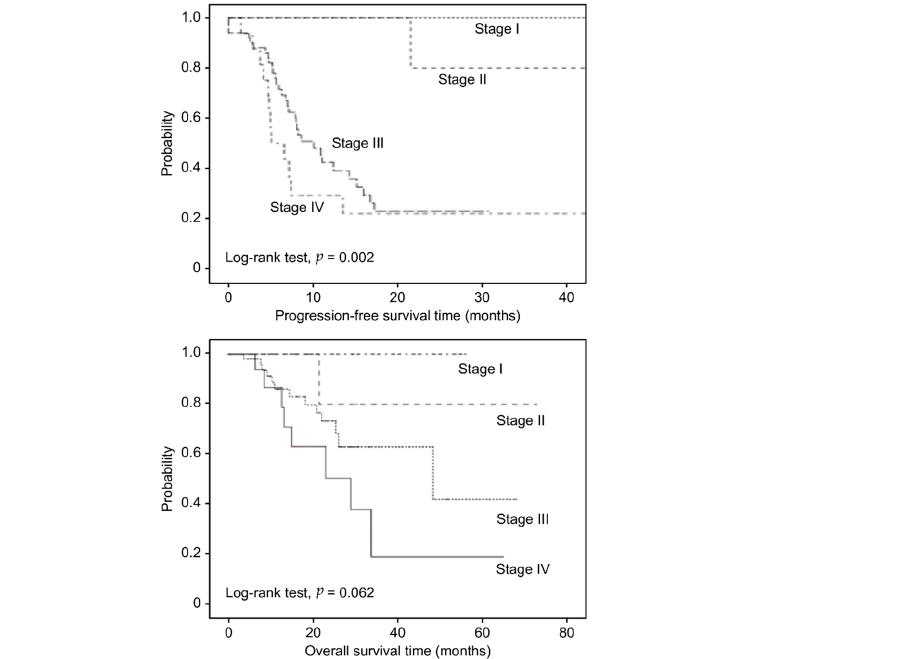
Figure 4. Kaplan-Meier analysis of overall survival and progression-free survival time in EOC pa- tients receiving BEV therapy based on FIGO stage.